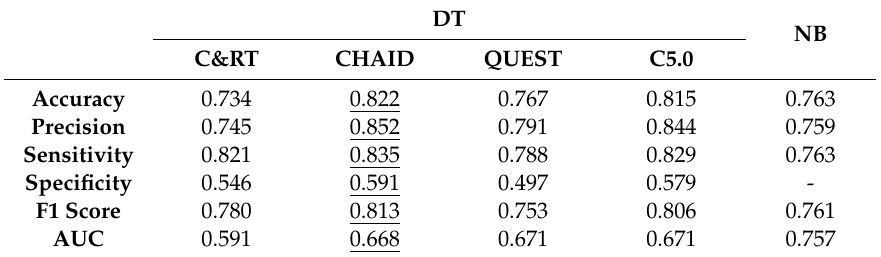
Table 1. Performance measures for decision tree (DT) and naïve Bayes (NB) methods (highest scores are